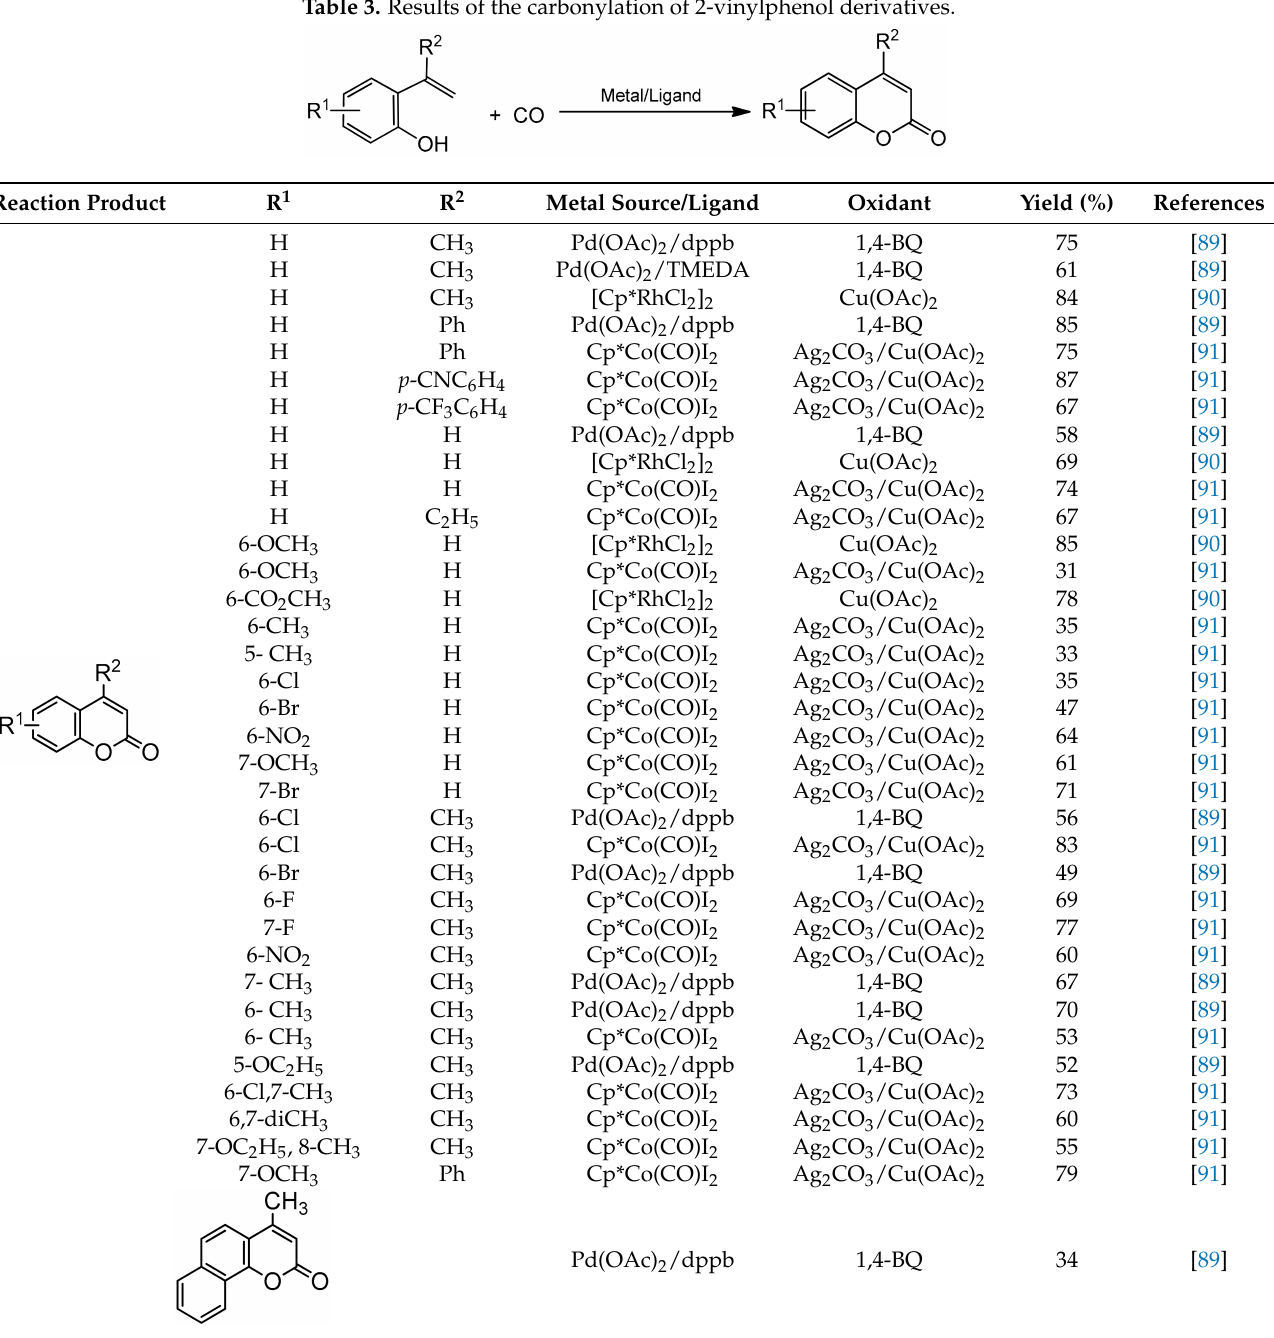
Table 3. Results of the carbonylation of 2-vinylphenol